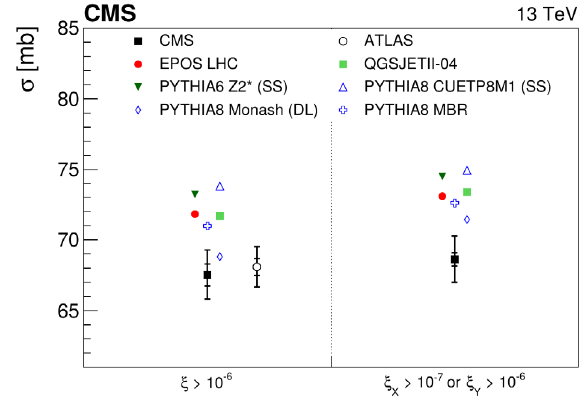
Figure 4. The detector-level inelastic cross section in proton- proton collisions measured for ξ > 10 − 6 and for ξ x > 10 − 7 or ξ y > 10 − 6 , see Ref.